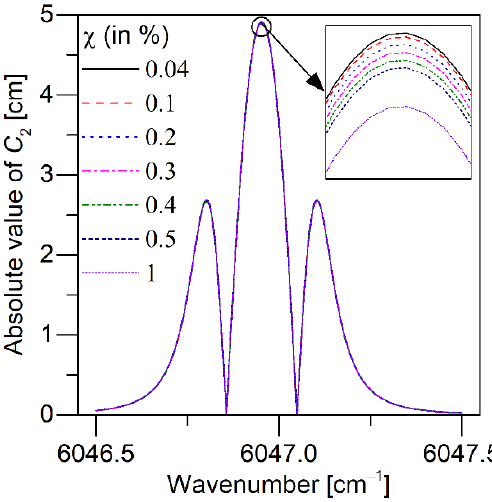
Figure 8. Absolute value of C 2 for different CH 4 mole fractions (400 ppm to